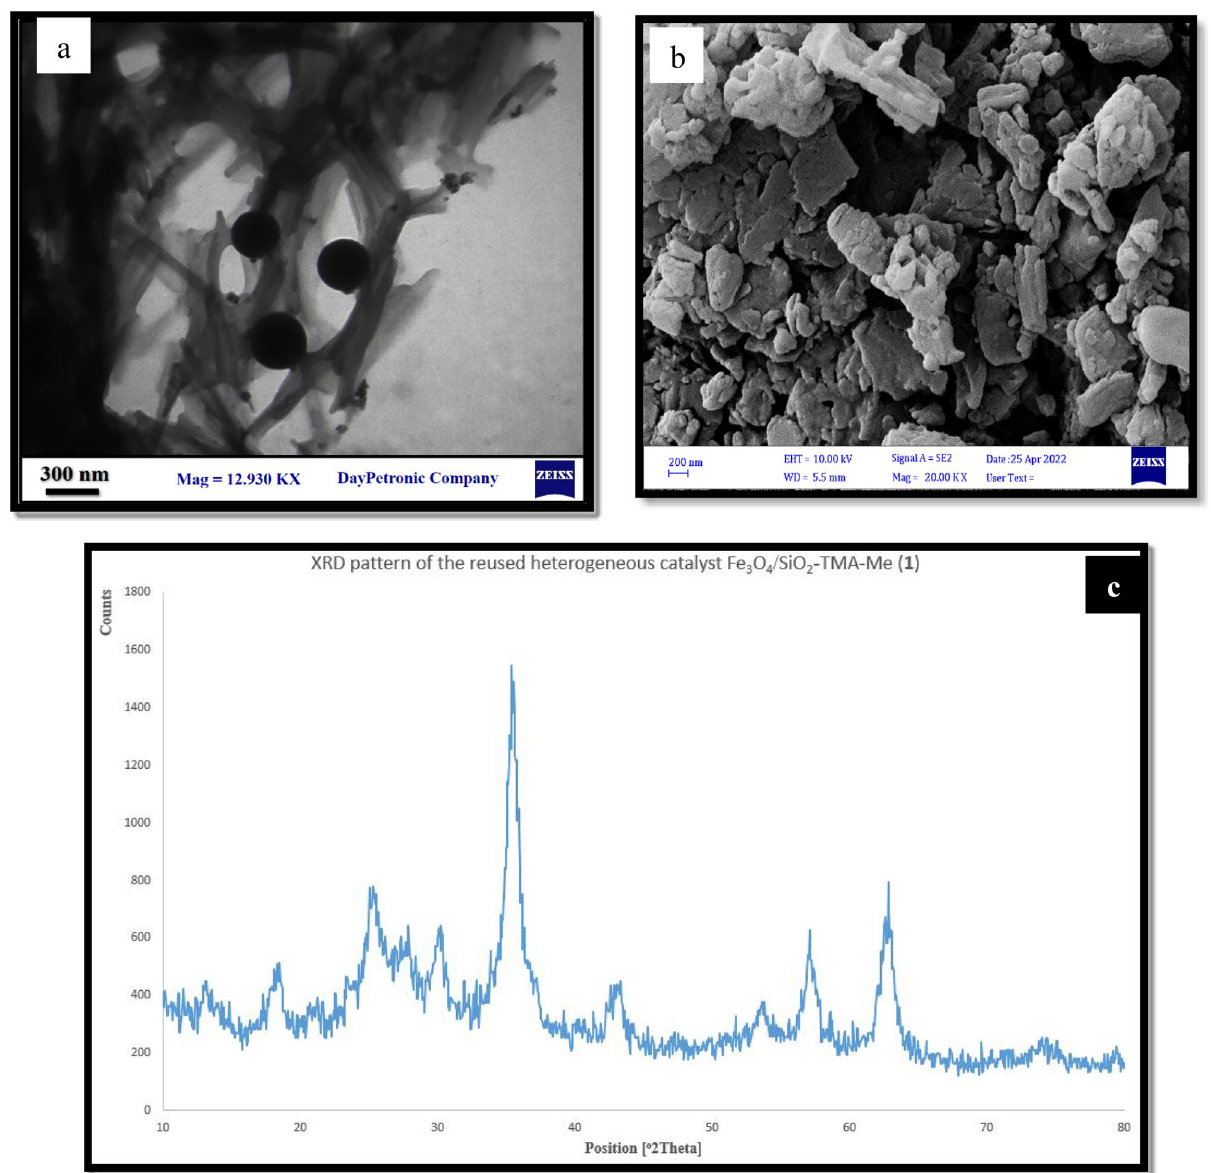
Figure 11. ( a ) TEM and ( b ) FESEM images and ( c ) XRD pattern of the reused Fe 3 O 4 /SiO 2 -TMA-Me heterogeneous acid ( 1 ) in the model reaction to afford 6a .